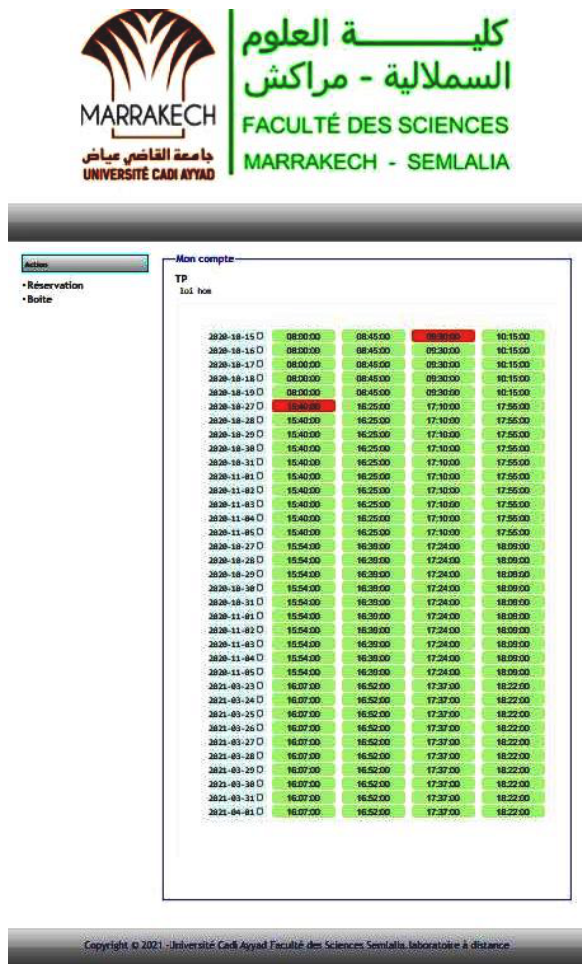
Figure 6. Student reservation interface